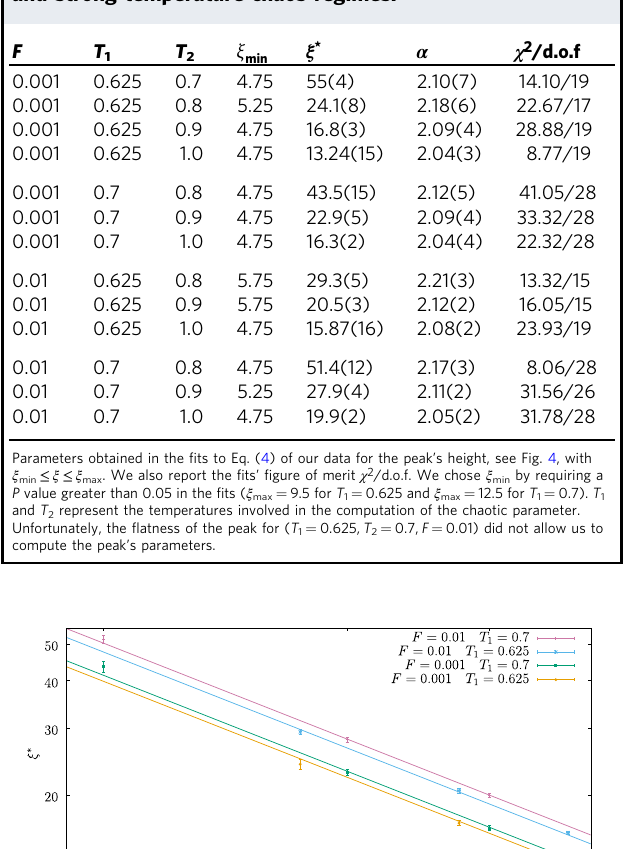
Table 1 Parameters describing the crossover between weak and strong temperature chaos regimes.